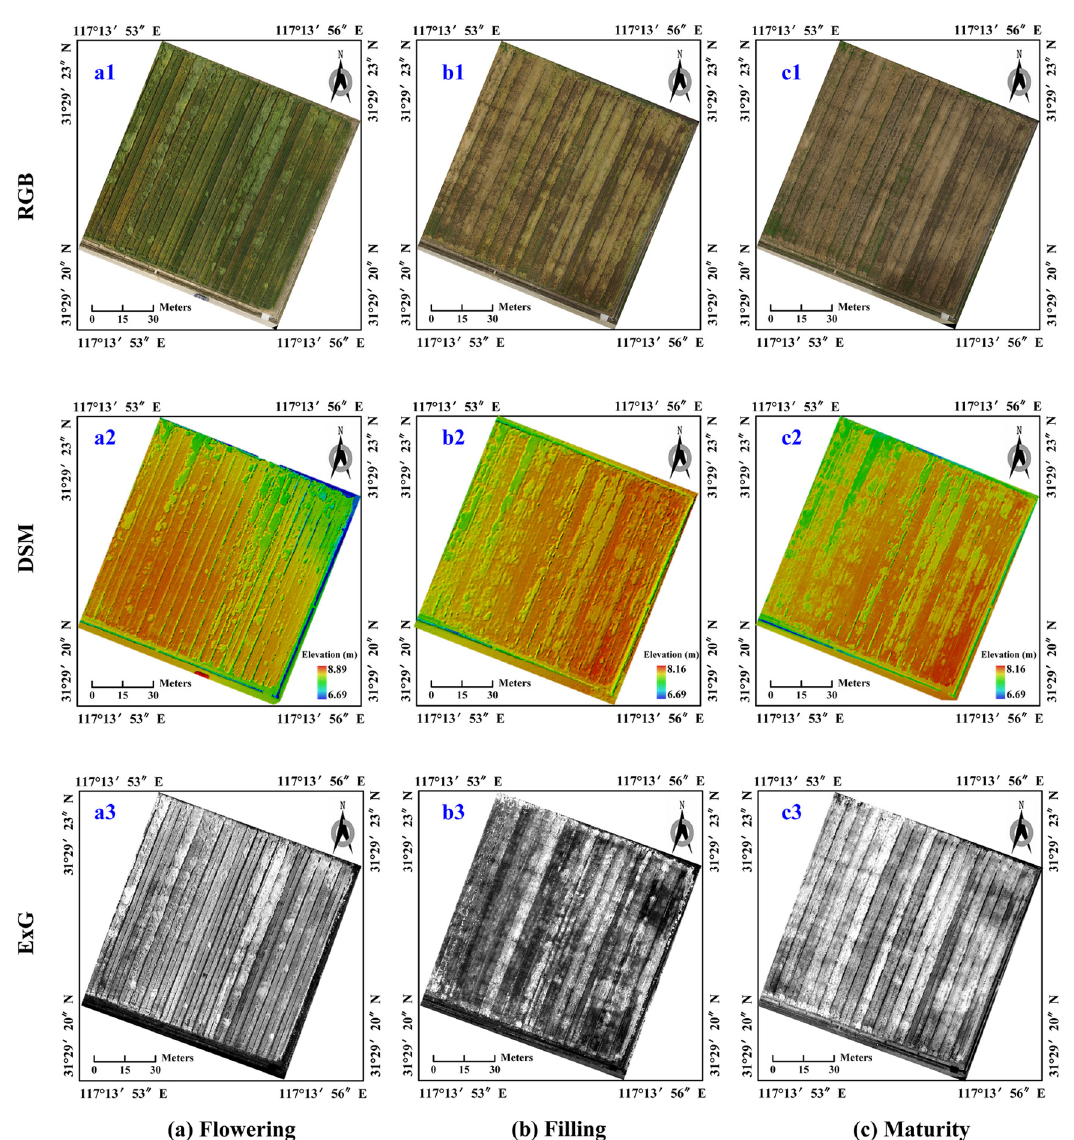
Figure 5. RGB, DSM and ExG of wheat fields in different growth periods: ( a ) flowering, ( b ) filling and ( c )